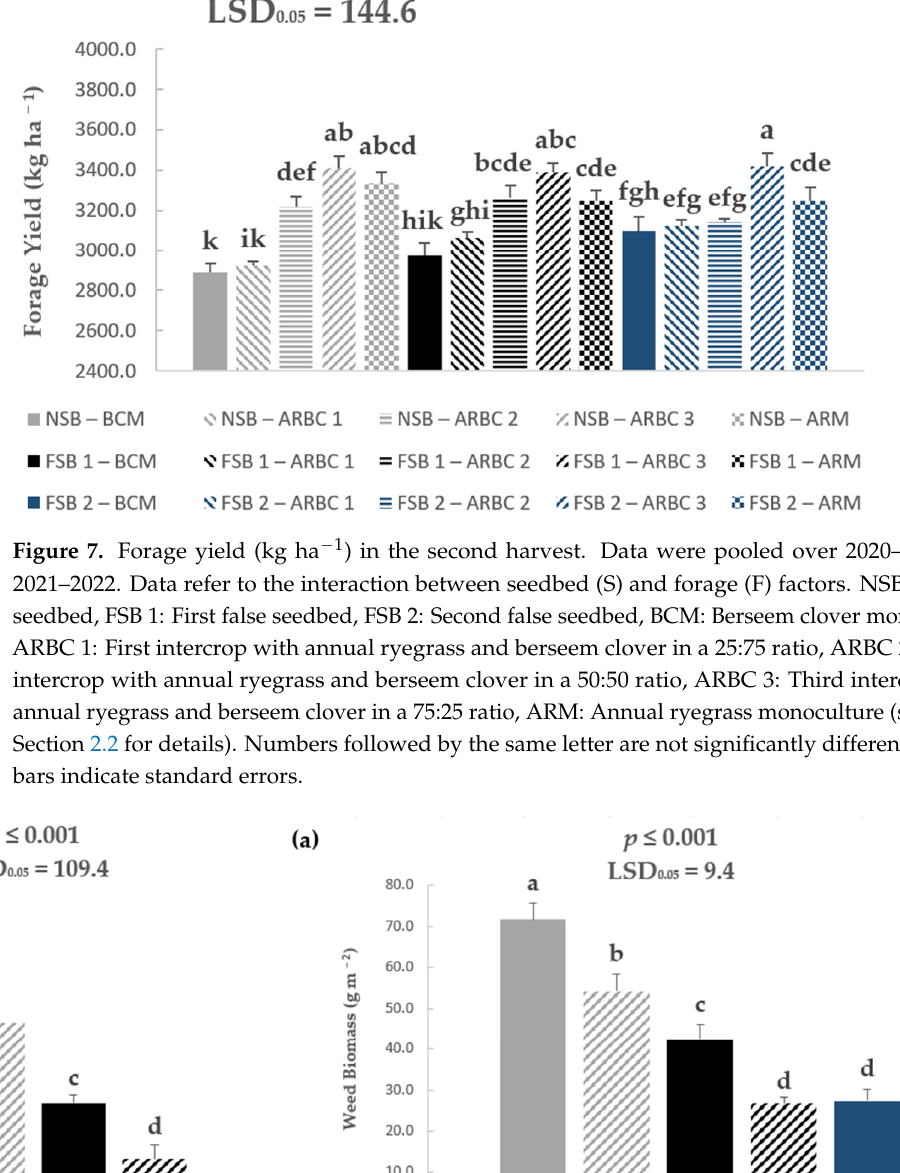
Table 7. Overall statistical analyses of degrees of freedom (for seedbed factor; for forage factor; for seedbed and forage interaction; for the error) and of the significance of effect (seedbed; forage; seed- bed and forage interaction and tests performed) on cumulative forage yield and biomass of berseem clover from two harvests. Data are presented separately for the two growing seasons (2020–2021 and 2021–2022). Factors DF 1 Forage Yield